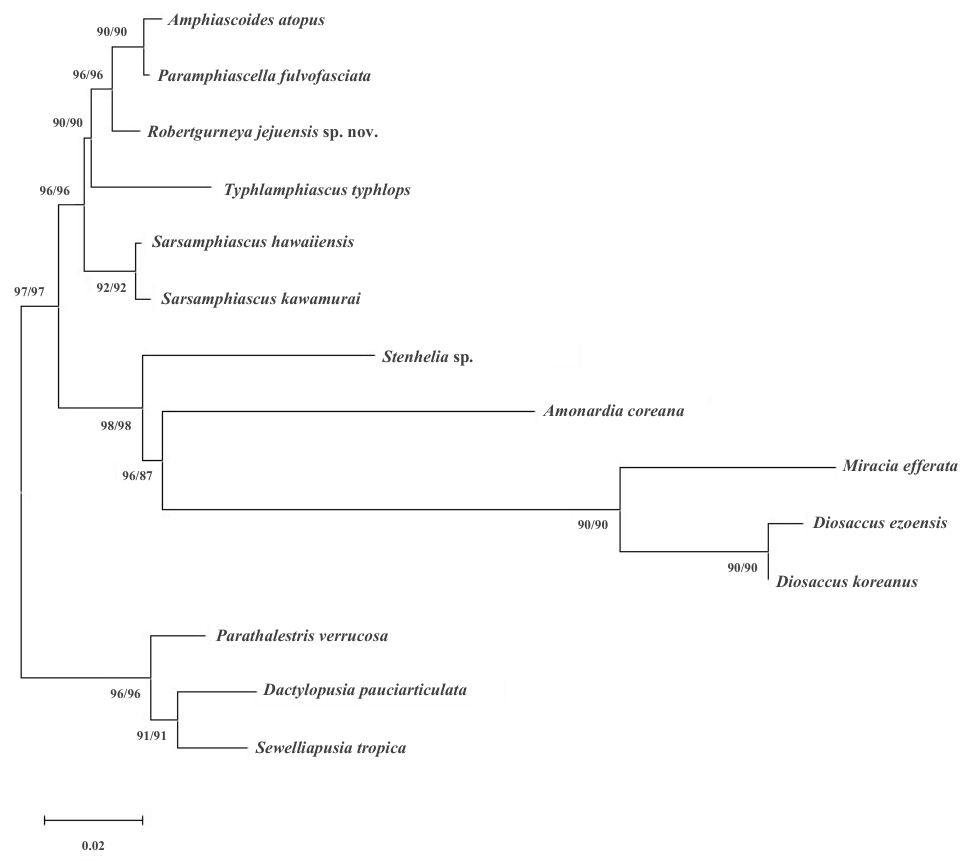
Figure 10. Maximum likelihood phylogenetic tree including nine genera of Miraciidae and outgroups based on 18S rRNA sequences. Tree shows bootstrap values (ML/NJ, %) together in one tree because the topologies of the two trees created in this study were the